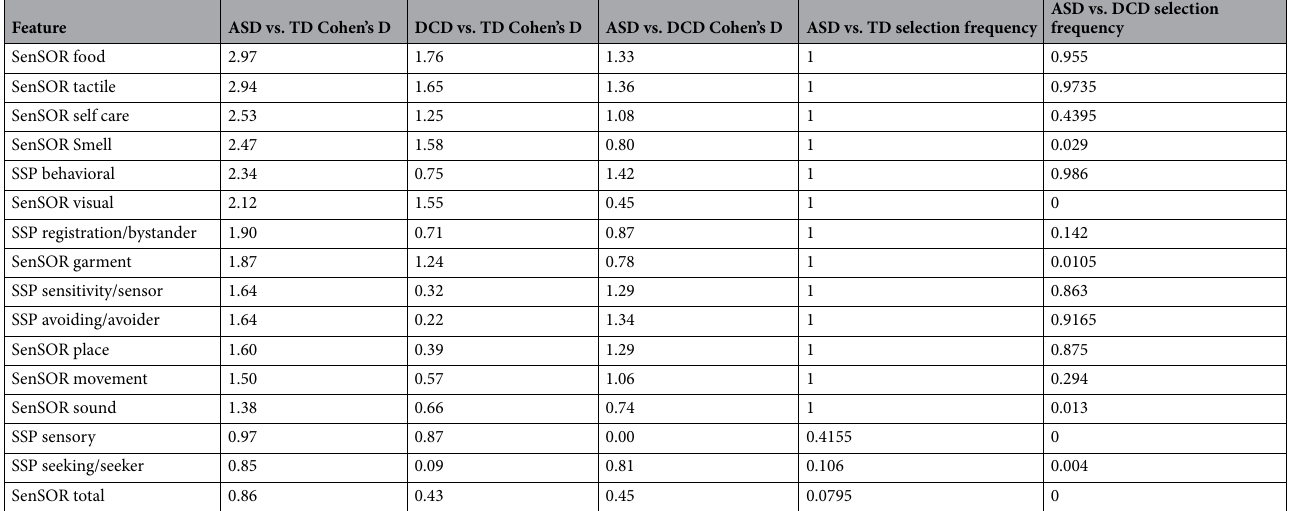
Table 2. Importance of sensory features in distinguishing ASD. The first three columns report Cohen’s d effect size from paired comparisons between subject groups. The last two columns report selection frequency of each feature by univariate feature selection for the full RDoC + M + S feature set across all 2000 cross validation loops for each of our two decoders (ASD vs. TD and ASD vs. DCD). Sensory features (rows) sorted by selection